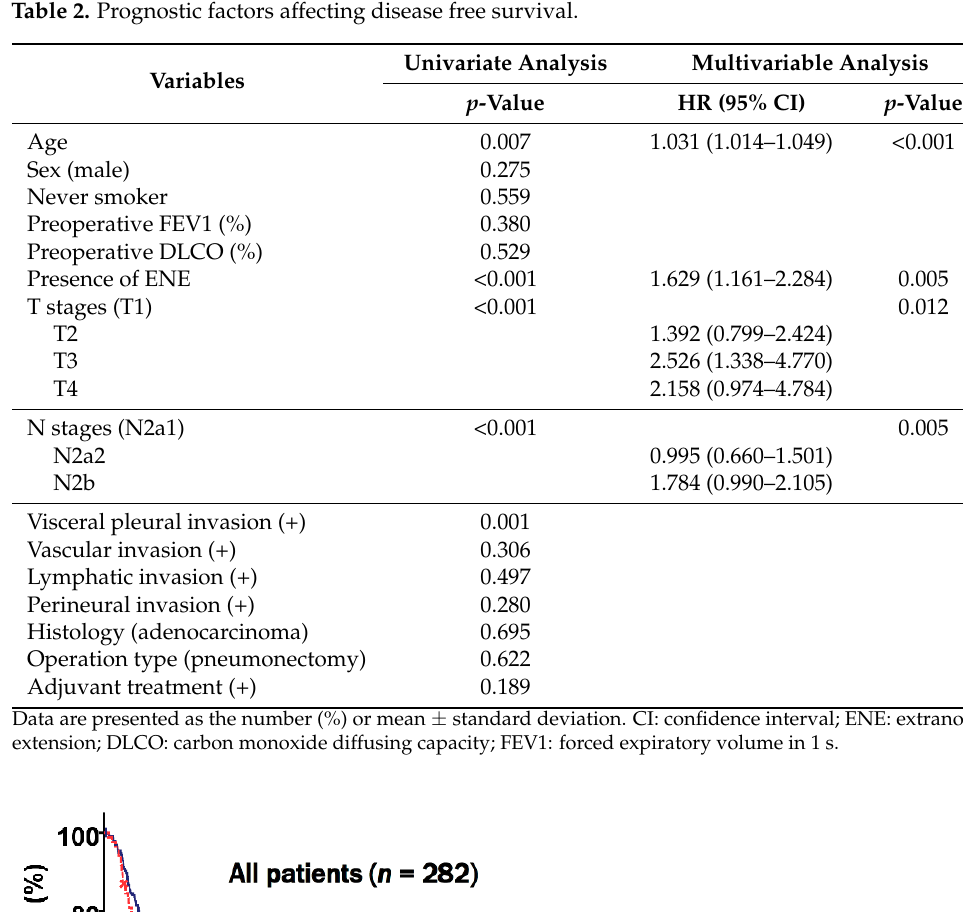
Figure 2. Disease free survival curve according to extranodal extension (ENE) status.